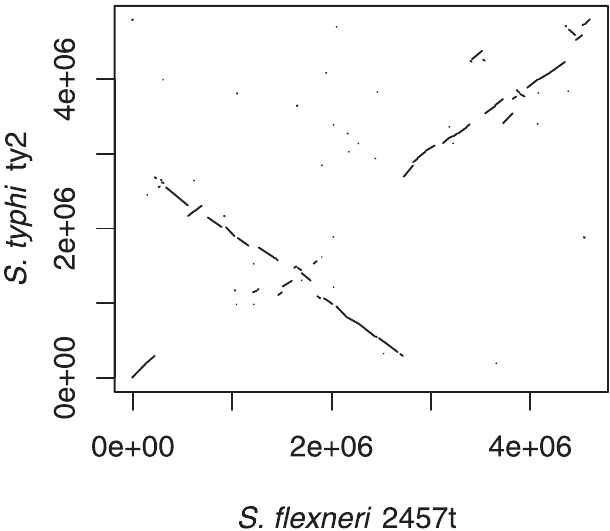
Figure 12. A Dot-Plot-Like Schematic Presentation of the Final One-to- One RF Table in the Comparison between S. flexneri 2457t (Horizontal Axis) and S. typhi ty2 (Vertical Axis) Each line in the figure corresponds to an entry in the table. Lines corresponding to entries with a positive sign are drawn parallel to the positive diagonal and lines corresponding to entries with a negative sign are drawn parallel to the negative